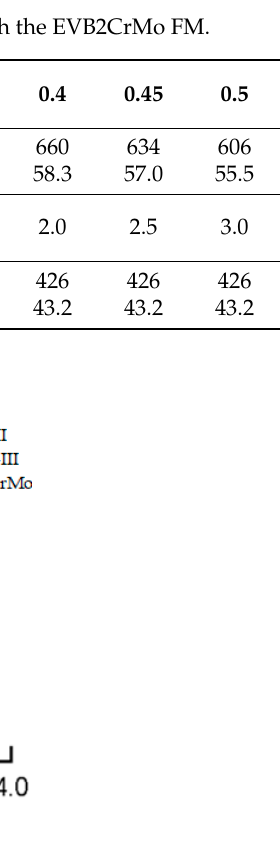
Figure 10. Microhardness measurement results on the inactive tooth flanks for the teeth hard-faced with FM DUR 600-IG and EVB2CrMo.